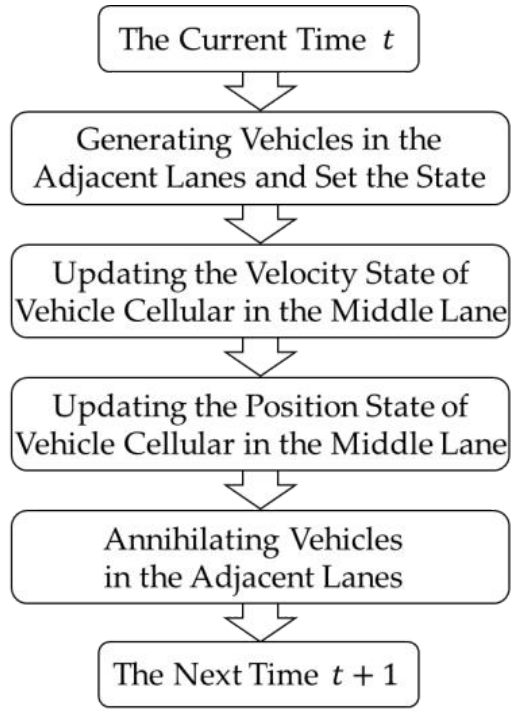
Figure 4. The evolution process of cellular states.